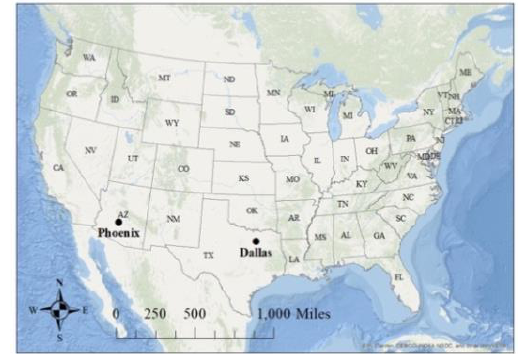
Figure 1. Map of cities studied